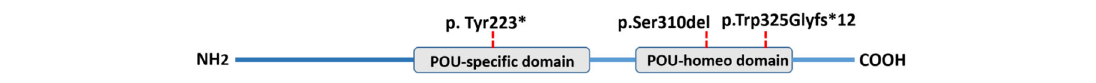
Fig. 4 Schematic illustration of the POU3F4 protein. In this study, three mutations were identified: the p.Tyr223*mutation located in the POU- specific domain, and the p.Trp325Glyfs*12 and p.Ser310del mutations located in the POU